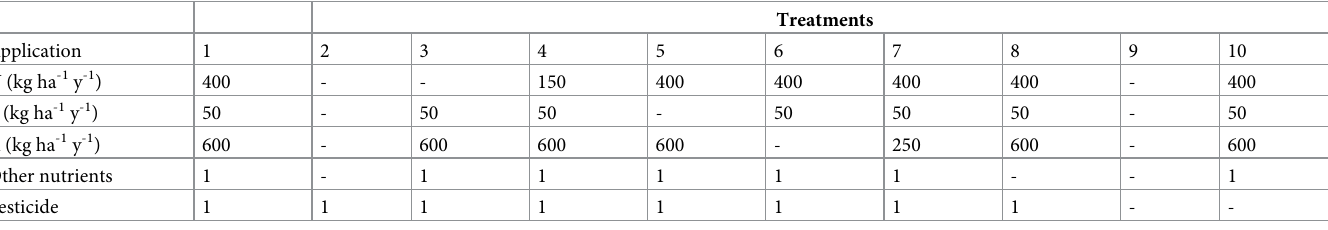
Table 2. Treatments applied in the nutrient omission trial.